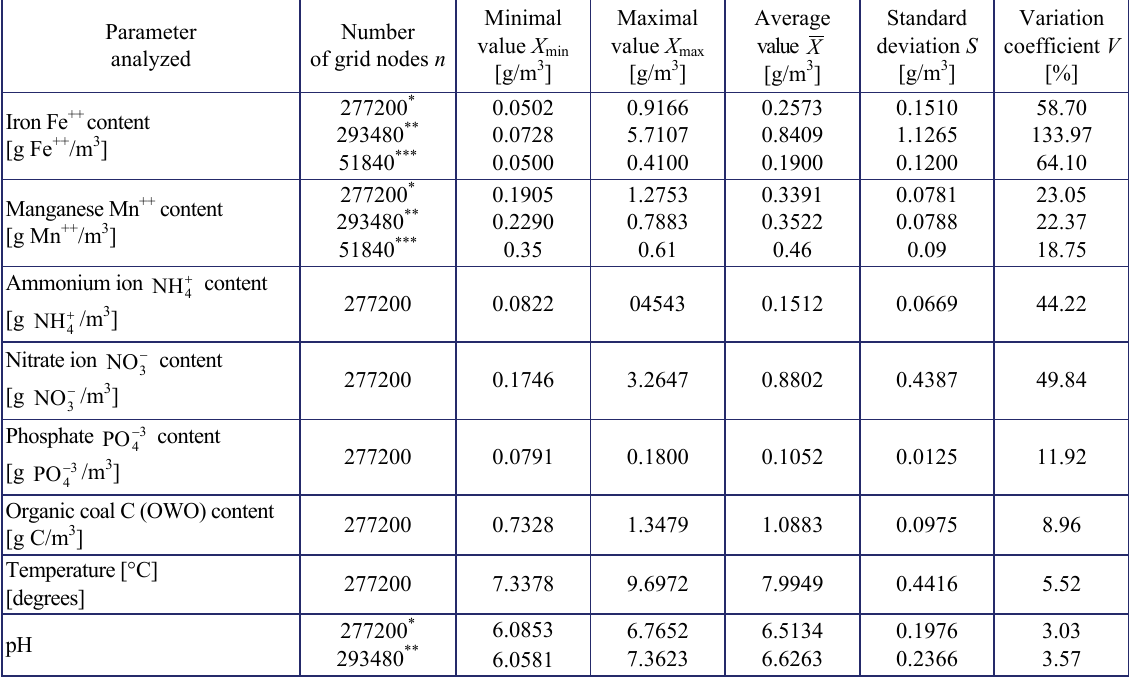
Table 10. Global statistics of estimated averages Z * of quality parameters of underground water;